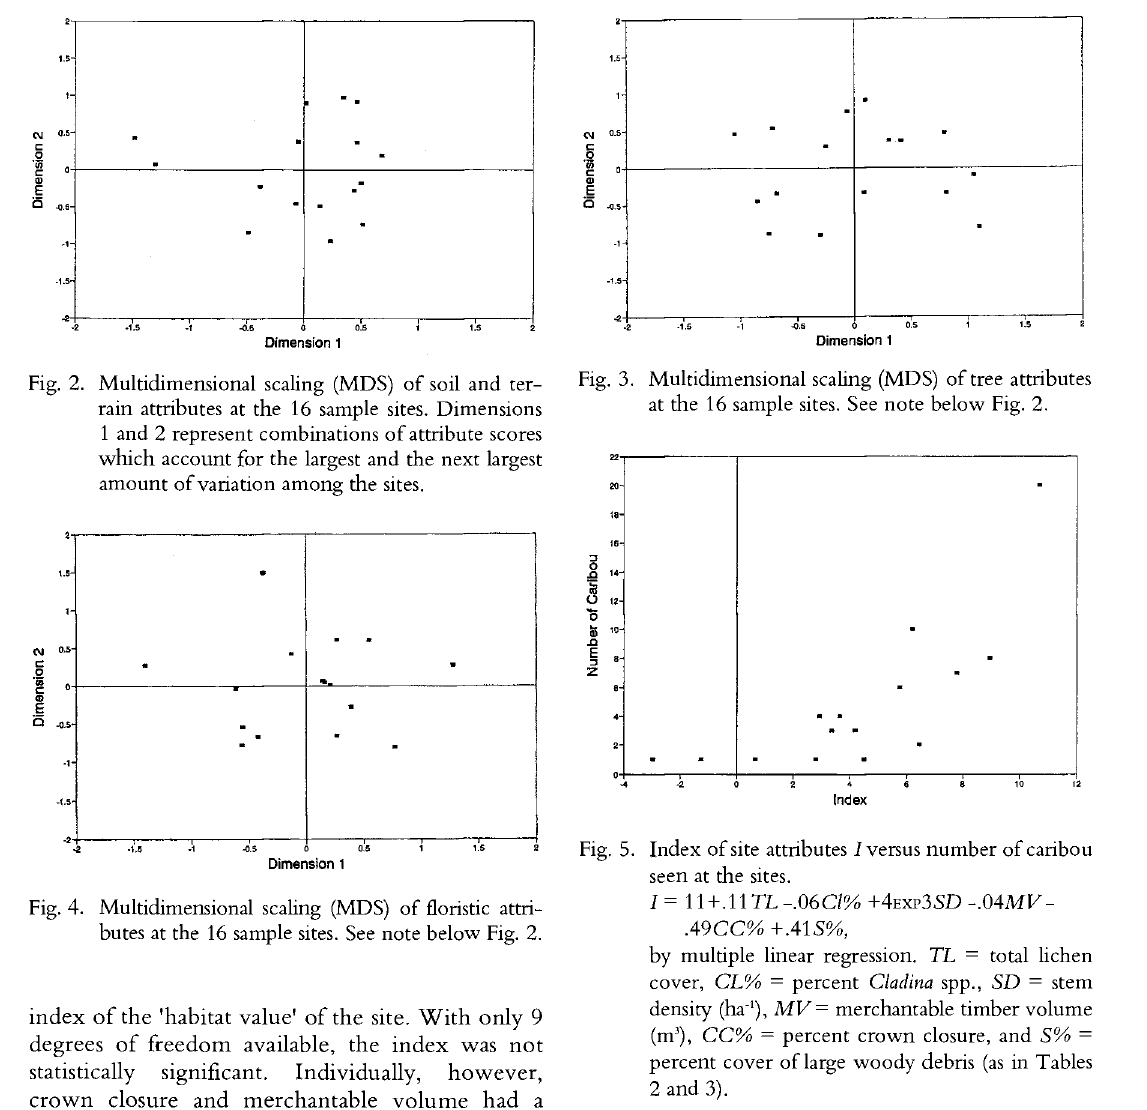
Fig. 5. Index of site attributes / versus number of caribou seen at the